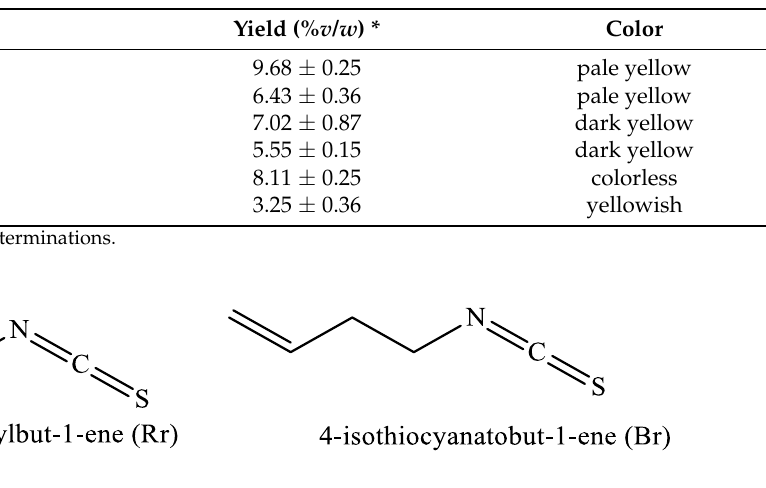
Table 2. The yield and color of the volatile oils of Brassicaceae seeds.